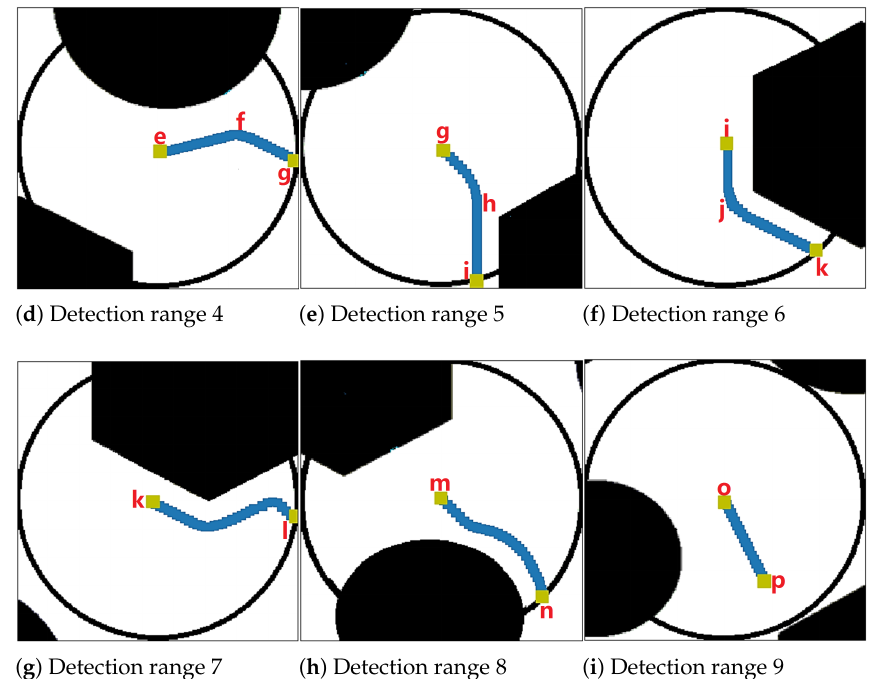
Figure 18. Local path planned in local environment.